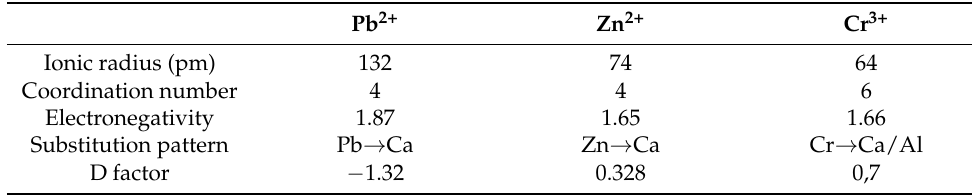
Table 2. Parameters of ions with substitution